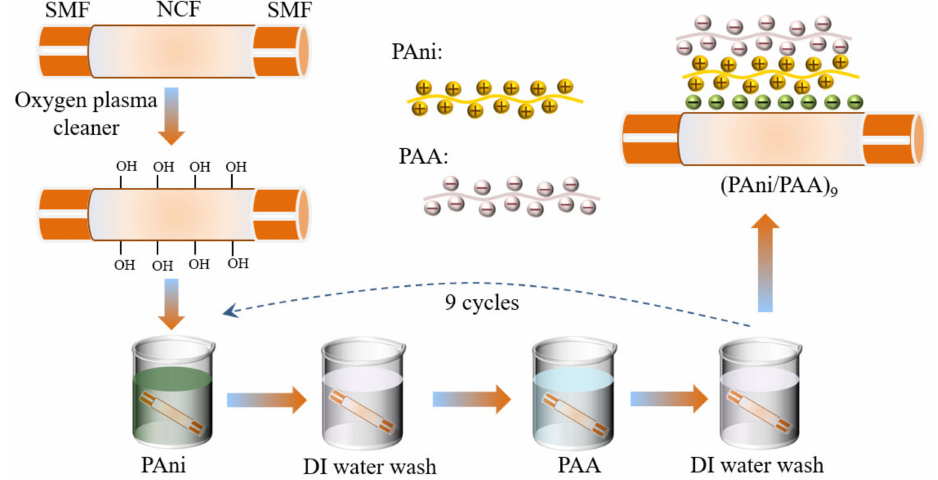
Figure 2. Fabrication of the SNS pH sensors by the LBL self–assembly